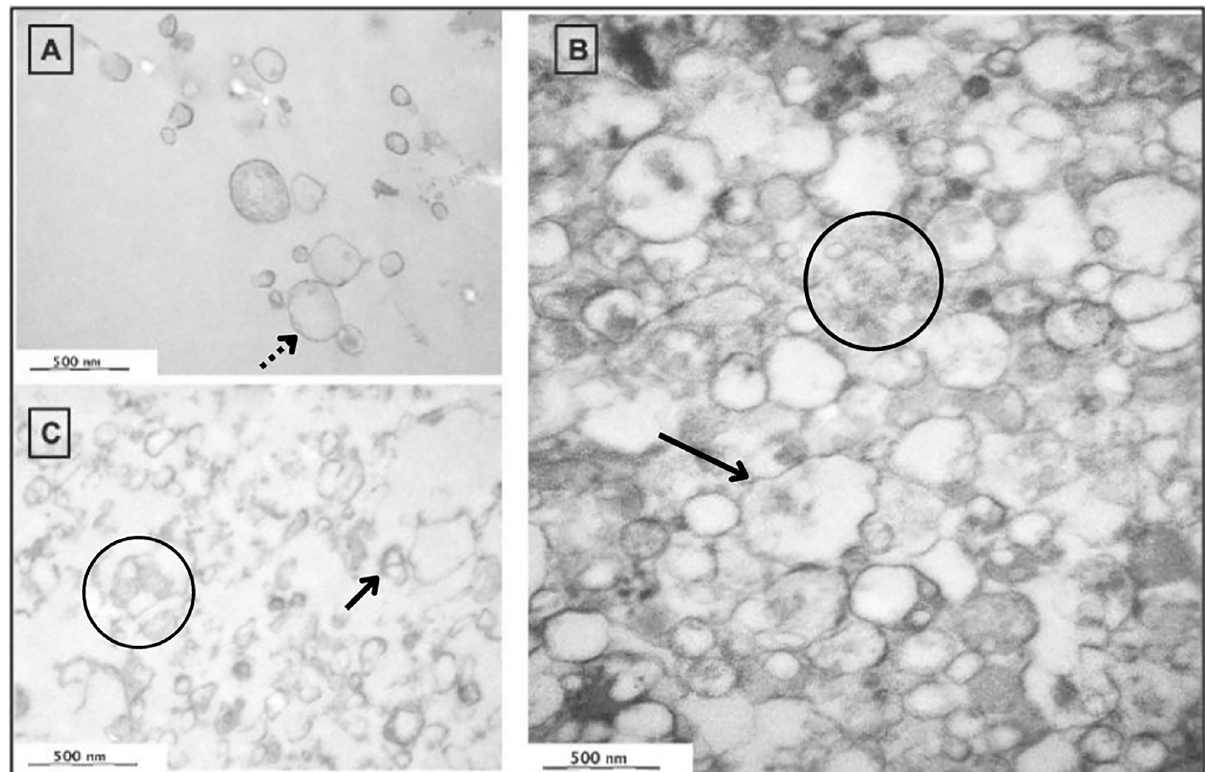
Fig 3. Smaller vesicles in a lower concentration, surrounded by a thin membrane (dashed line arrow) could be observed during the TEM analysis of aseptic samples (A). Acute septic samples (B) showed a markedly higher number of vesicles with a thin, irregularly shaped membrane (arrow) and containing a dense cargo (circle). The same dense material could be seen also outside the vesicles (circle). Low-grade septic samples (C) provided more vesicles than aseptic aspirates, the EVs were larger than aseptic particles with a thick wall (arrow) and a dense substance inside them (circle). (Magnitude: 30x and the markers show the 500 nm size